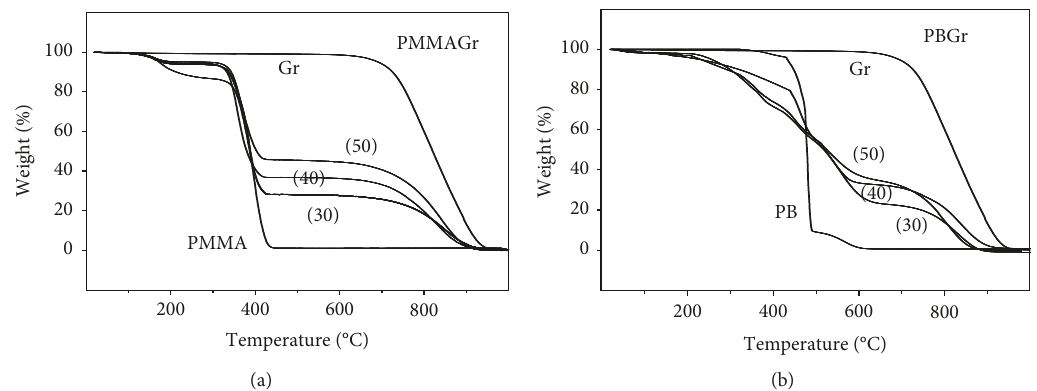
Figure 2: TGA thermograms of polymer/graphite composites used in this work. (a) PMMA/graphite composite fi lms (PMMAGr) and (b) PB/graphite composite fi lms (PBGr). The numbers enclosed in parentheses represent the graphite amounts in the composite fi lms. PMMA, PB, and Gr indicate poly(methyl methacrylate), polybutadiene, and graphite, respectively. The measurement was conducted in an air fl ow of 40cc/min. The heating rate was 5 °